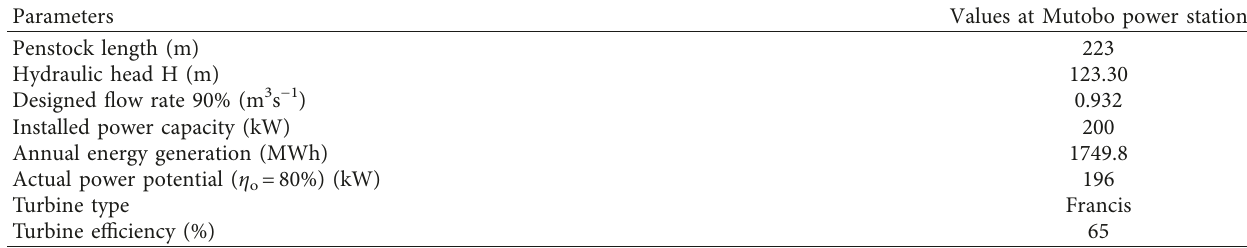
Table 1: Technical information for Mutobo hydropower station.